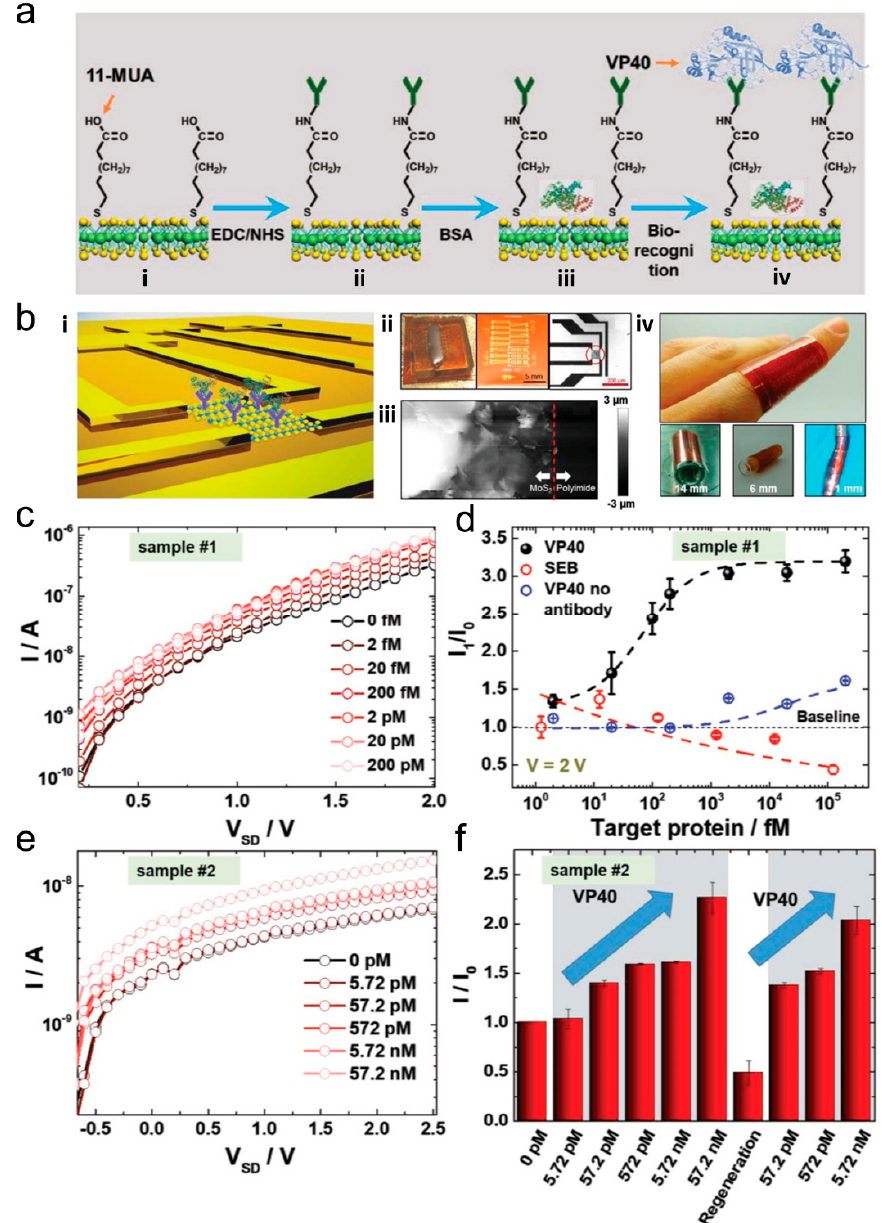
Figure 5. Electrochemically exfoliated MoS 2 for stacking MoS 2 flakes on the polyimide substrate to detect Ebola virus VP40 matrix protein. ( a ) Biofunctionalization of the MoS 2 nanoflakes for capturing VP40. ( b ) Fabrication of flexible MoS 2 biochip with VP40 sensors. ( c ) Electric current measurements after the incubation of various VP40 concentrations on a sensor with a high amount of flakes. ( d ) Calibration of the response and comparison with control sensors (no antibody and non-specific antigen). ( e ) Repeated electric current measurements after the incubation of various VP40 concentrations on a sensor with a low amount of flakes. ( f ) The device could be reused to probe VP40 after antibody-antigen dissociation, and repetition of the tendency result remained similar after analyte incubation. Figures are re-arranged and reprinted with permission from Ref. [83]. Copyright Wiley-VCH.